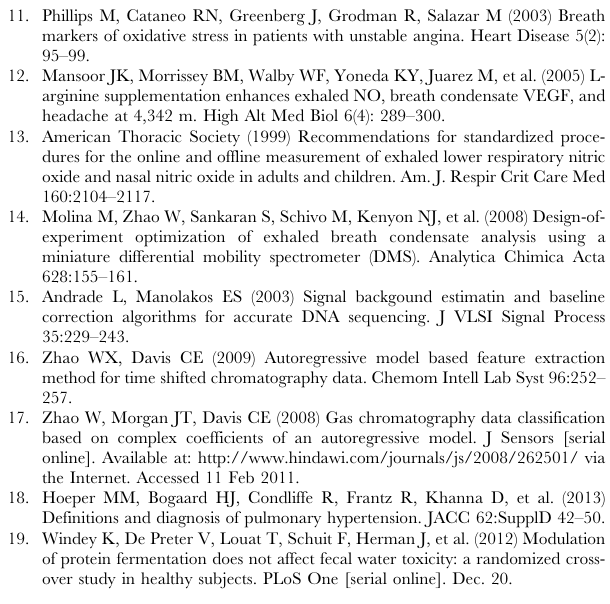
Table S1 Concomitant medication/supplements list for IPAH subjects. Number of subjects taking each medication in parenthe- ses.